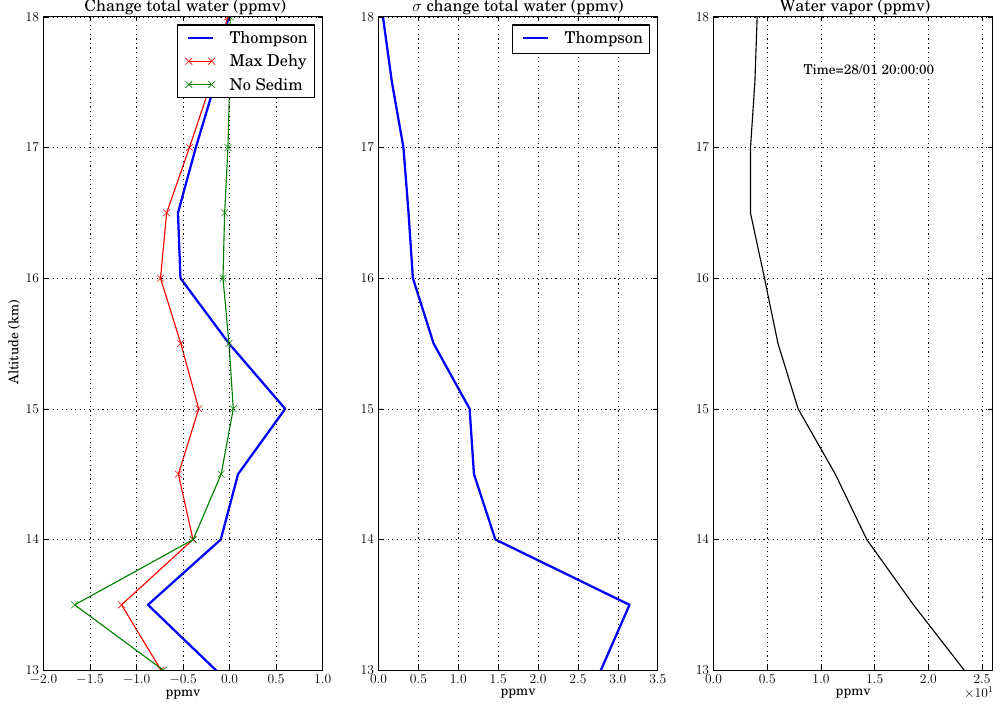
Figure 11. (Left) Change in water vapour between the start of the simulation (27 January 2009, 00:00) and 28 January 2009, 20:00, i.e. after 44h of simulation, for three simulations: “Thompson” in blue (Thompson microphysics scheme), “Max Dehy” or “Maximum Dehydration” in red (removal of water vapour above 100% relative humidity) and “No Sedim” or “no sedimentation” in green (sedimentation turned off for temperatures below 220K). See text for details of the methodology of evaluation of the redistribution. (Middle) Standard deviation of the water redistribution for the “Thompson” full microphysics case; this emphasizes the variability and uncertainty in the estimate. (Right) Mean water vapour profile in the